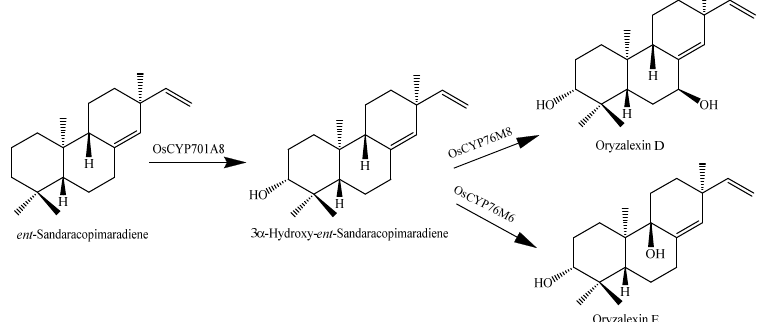
Figure 13. Biosynthesis pathways showing ent -sandaracopimaradiene dihydroxylation into oryzalexins D and E [144].